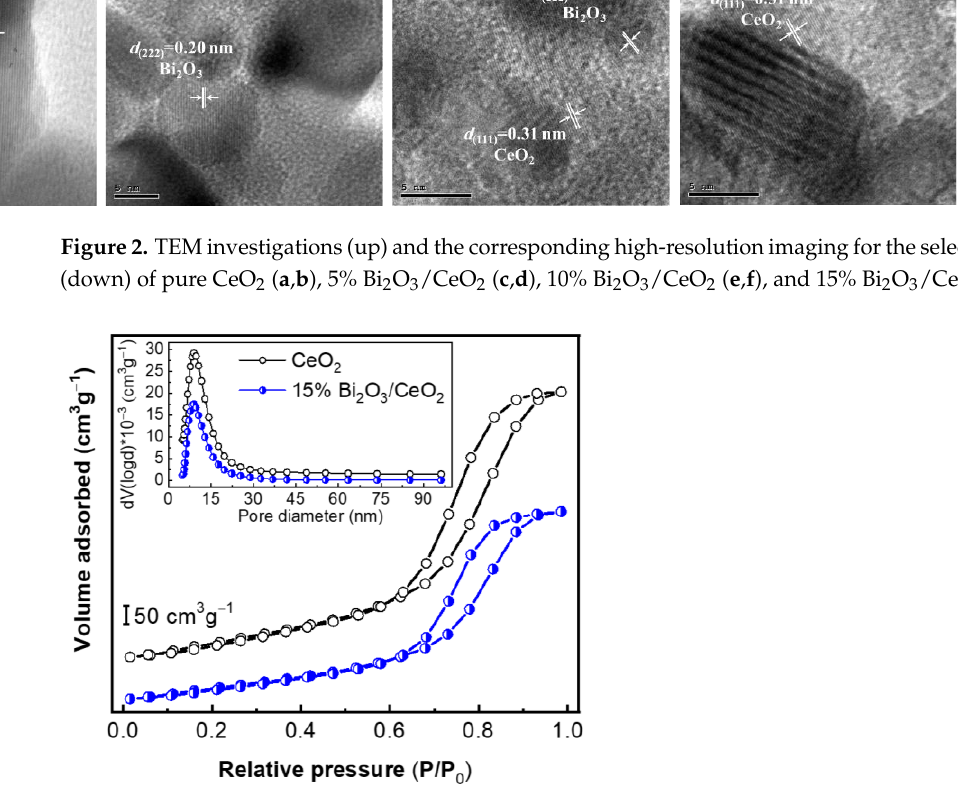
Figure 2. TEM investigations (up) and the corresponding high-resolution imaging for the selected area (down) of pure CeO 2 ( a , b ), 5% Bi 2 O 3 /CeO 2 ( c , d ), 10% Bi 2 O 3 /CeO 2 ( e , f ), and 15% Bi 2 O 3 /CeO 2 ( g , h ).